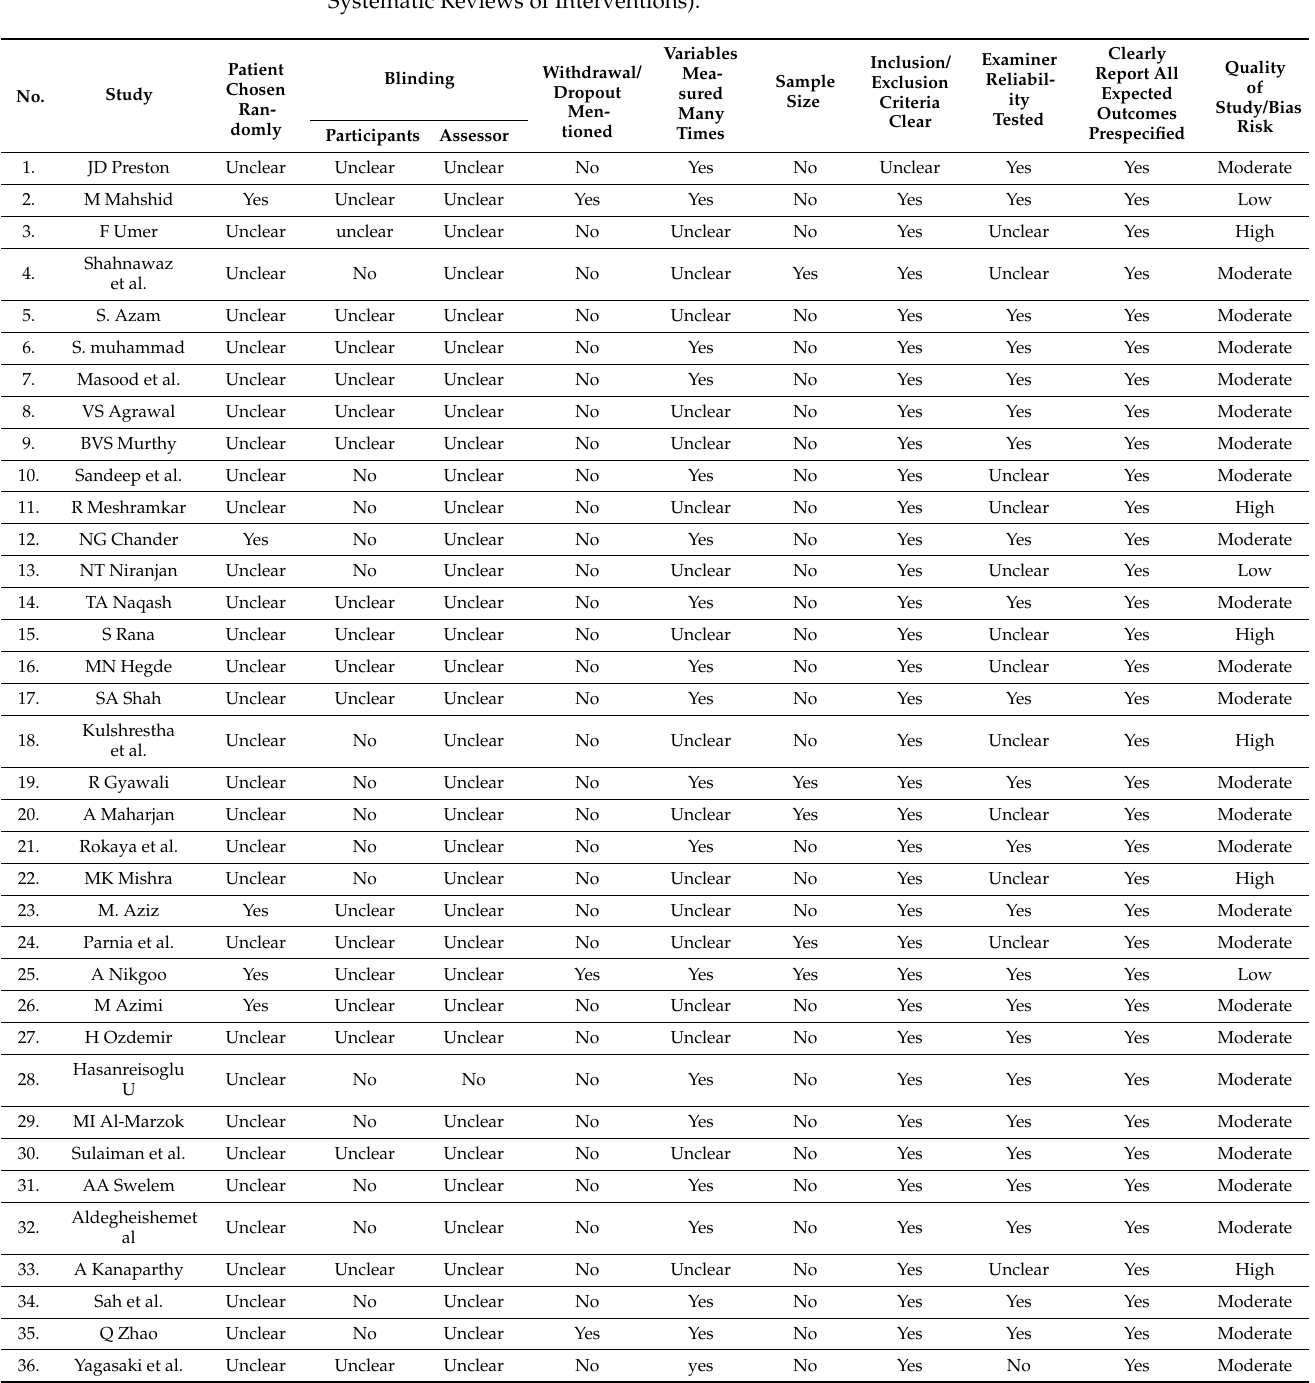
Table 7. Methodological quality assessment results of the included studies (Cochrane Handbook for Systematic Reviews of